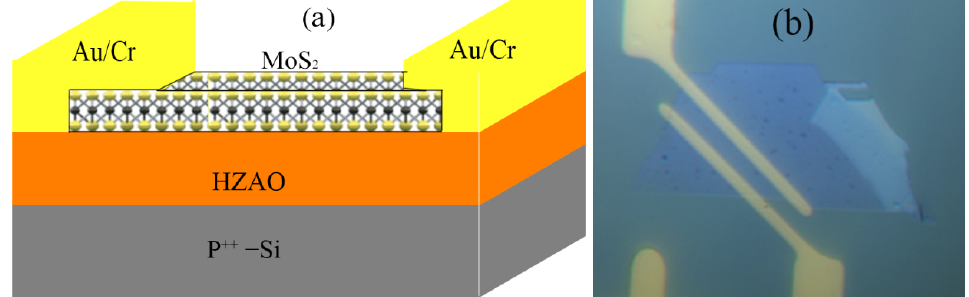
Figure 1. ( a ) Schematic diagram and ( b ) optical micrograph of a back-gated HZAO NCFET.